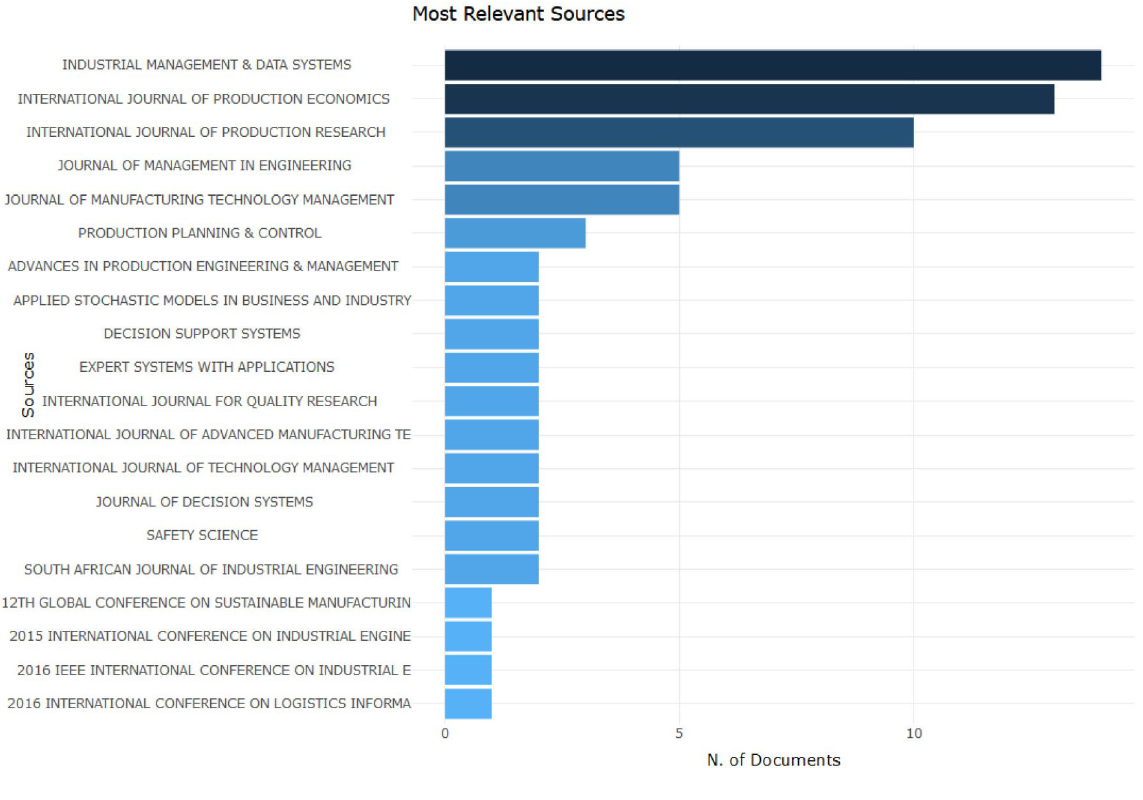
Figure 2. Journals with most analyzed publications